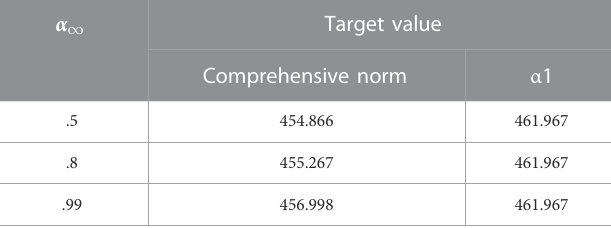
TABLE 7 Comparison of result between comprehensive norm-inf and